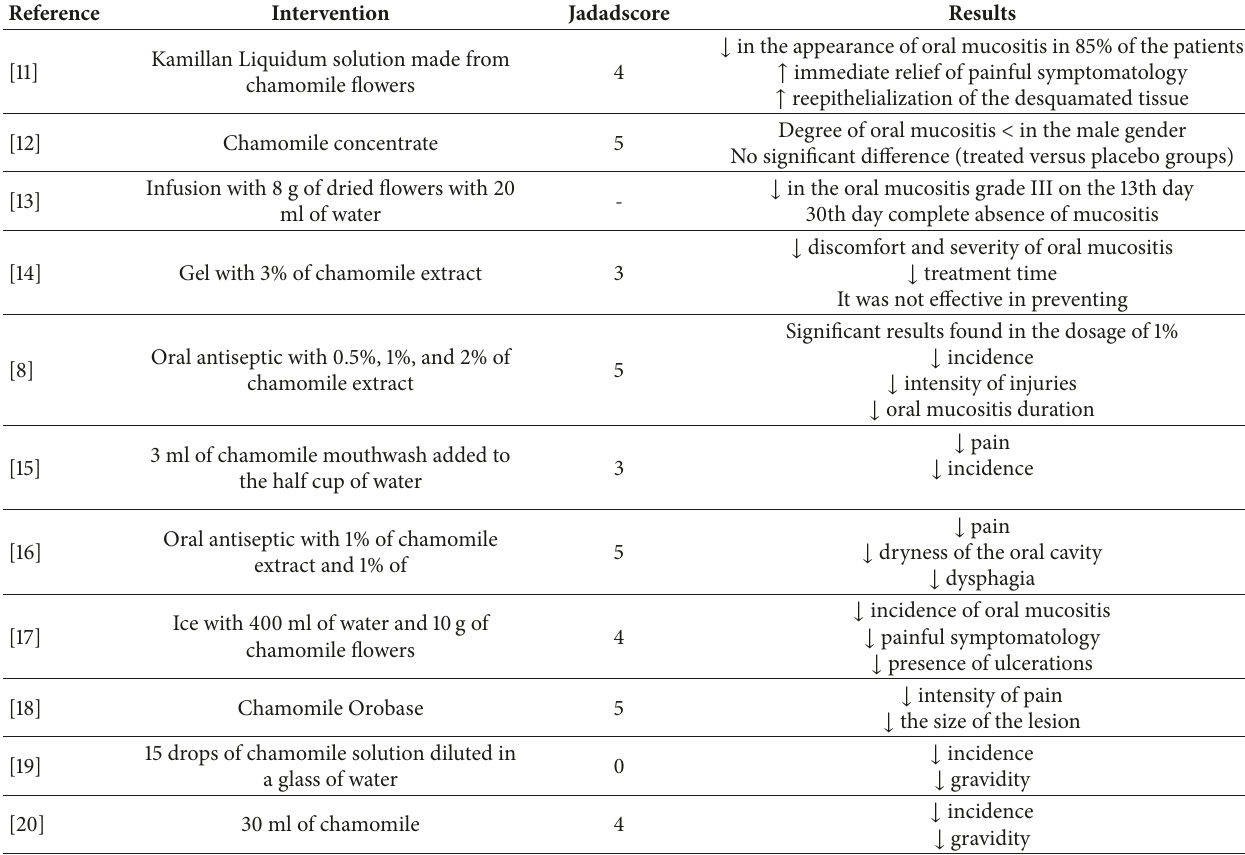
Table 3: Clinical trials on the effectiveness of Matricaria